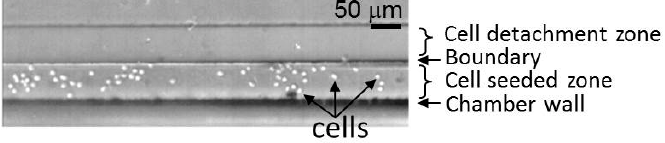
Figure 5. Cells seeded in a line pattern using the laminar flow.